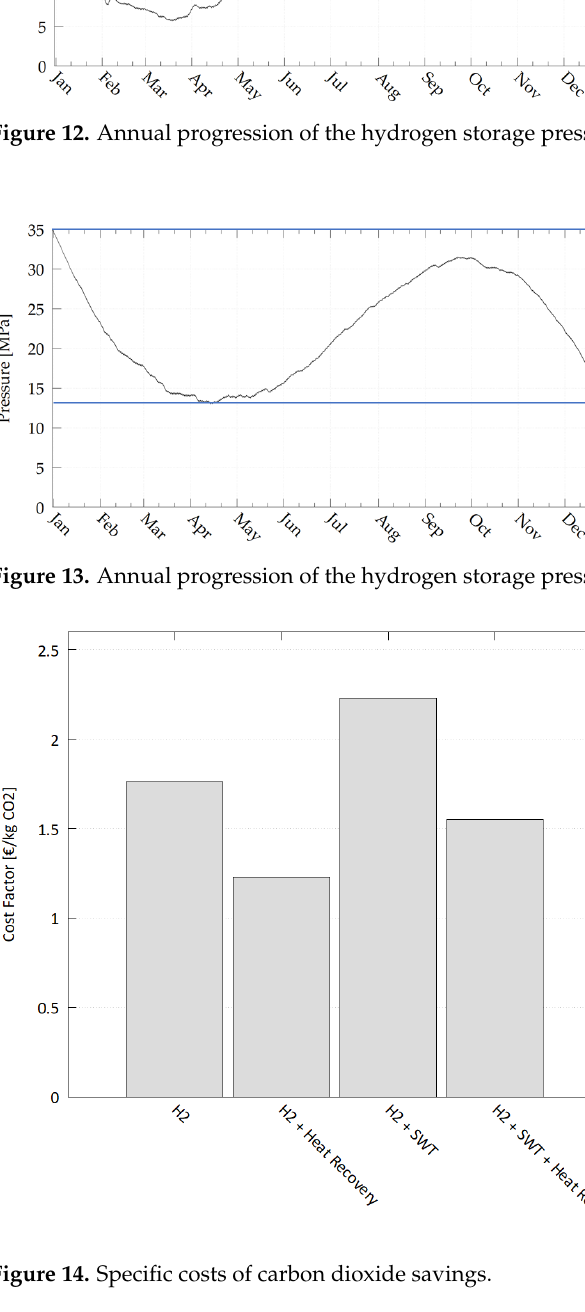
Figure 14. Specific costs of carbon dioxide